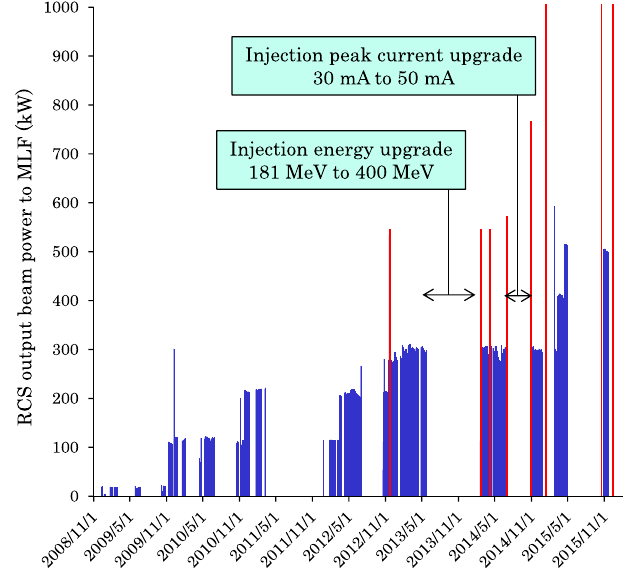
FIG. 2. Beam power ramp-up history of RCS since the start-up of user programs in December 2008, where the blue bars correspond to the beam power in the routine user operation at 25 Hz, while the red ones show the equivalent beam power achieved by the beam-on-demand single-shot mode in the beam test.